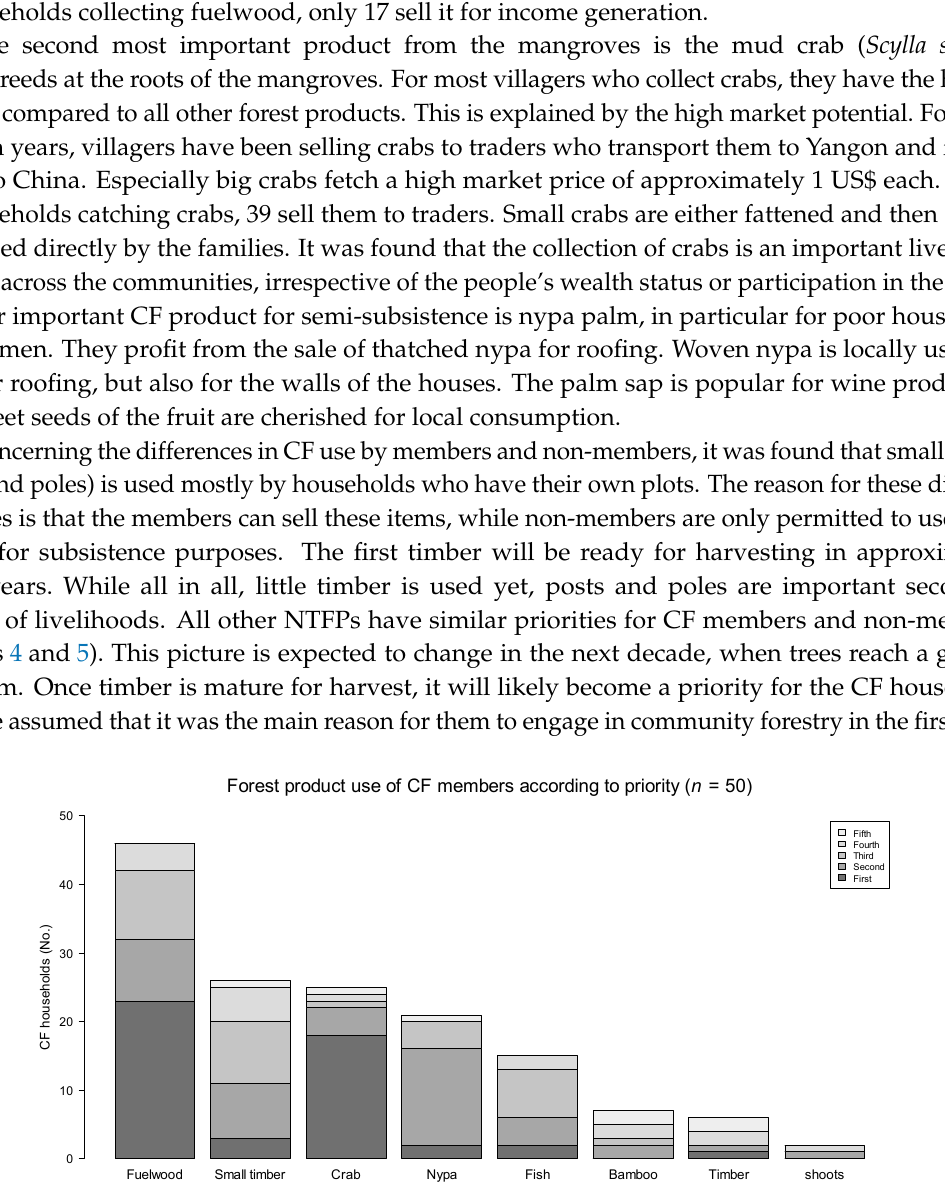
Figure 5. Use and importance of mangrove products by non-members of the CFUG. Fuelwood is used more by CF members (92% of households) than non-members (65%, Figures 4 and 5). A possible explanation is that non-members, who go less often to the CF, prefer to take fuelwood from their homegardens. They can take fallen branches (e.g., from coconut) from other homegardens for subsistence purposes, provided that they have sought permission from the owner beforehand. Crab collection also has a higher priority among the CFUG. This could indicate that membership could possibly bring advantages for crab collectors. However, current data are not enough to confirm this argument. In addition to the main CF products illustrated in Figures 4 and 5, minor products can be found in some of the mangrove areas and are generally used for subsistence. They include clams, snails and shrimp, as well as a type of climbing plant, which is used in a local curry dish. Non-material goods also contribute to local livelihoods in a wider sense and improve their non-financial assets, in particular the natural assets. The community as a whole benefits from the ecosystem services provided by the established mangrove plantations. The protection they provide from storms and floods is well known. Experiences from Cyclone Nargis show that mangroves are an important safety net in the aftermath of natural disasters. After the cyclone, the forests were degraded due to overuse by the local population. They mainly used small timber to rebuild houses,